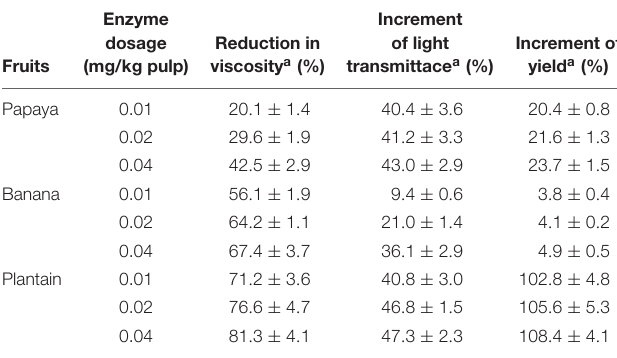
TABLE 2 | Application of PoxaEnPG28B-Pp in fruit juices production at 65 ◦